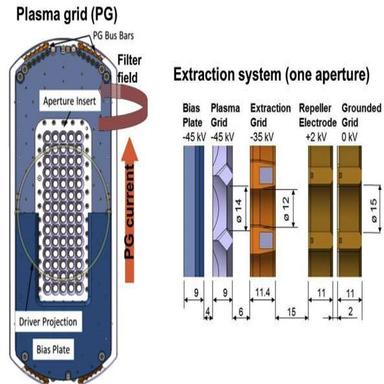
View onto the plasma grid with the projection of the driver indicated. The extraction system is shown for one aperture; dimensions are in mm.